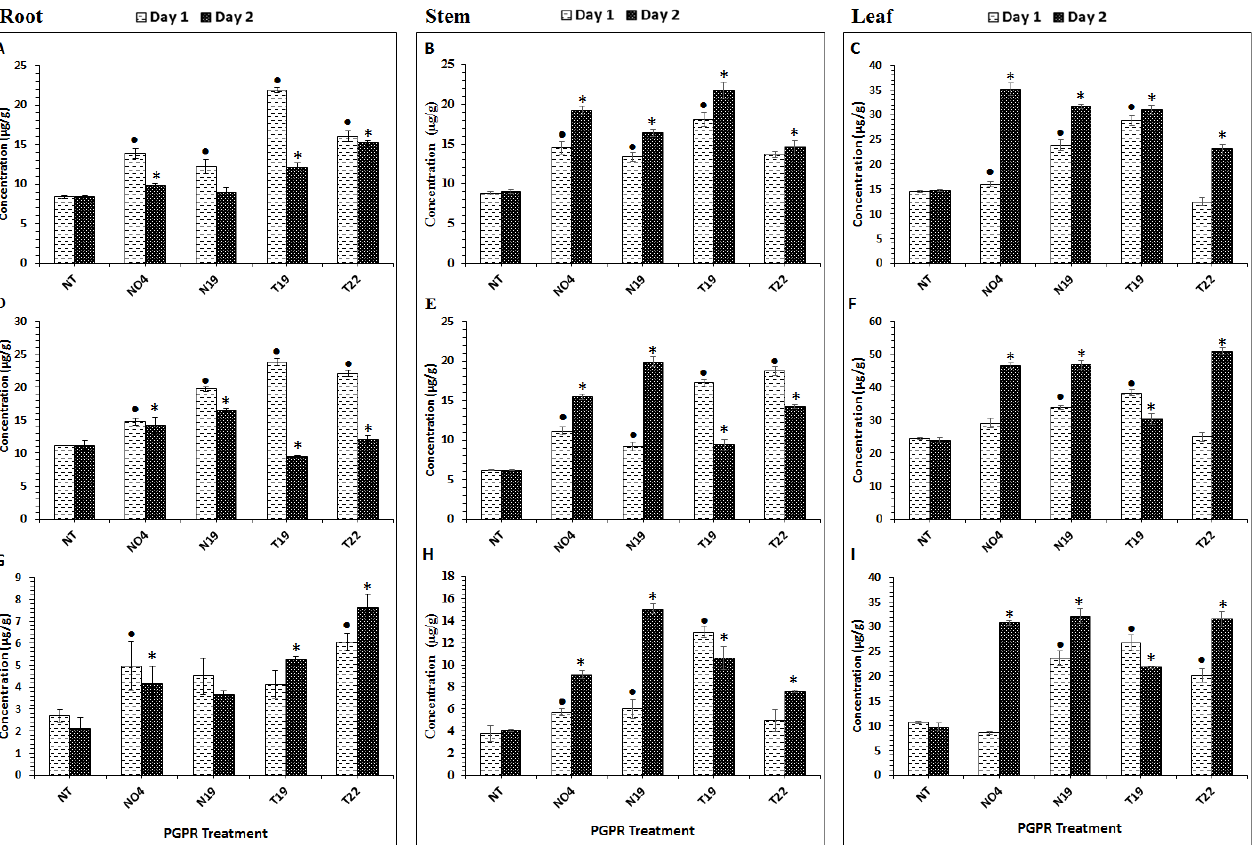
Figure 1. Plant growth – promoting rhizobacteria (PGPR)-induced changes in aromatic amino acid concentrations in tomato plant tissues. ( A – C ) : Phenylalanine, ( D – F ) : Tryptophan, ( G – I ) : Tyrosine. The values are means ± SD ( n = 3 independent samples). Extracts were prepared from 200 mg of root, stem and leaf tissue, and all concentrations are expressed as µg/g fresh weight (FW). NO4= Pseudomonus fluorescens ; N19 = Pseudomonus koreensis ; T19 = Paenibacillus alvei ; T22 = Lysinibacillus sphaericus . An asterix (*) or a dot (•) indicates the statistical significance with a p -value < 0.05 compared with the non- treated (NT) plants. • = comparison on day 1 post-inoculation; * = comparison on day 2 post-inoculation.